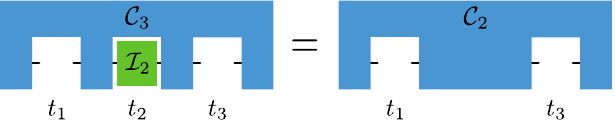
FIG. 6. Generalized marginalization for combs. Letting a comb defined on times T act on identity maps at a set of times T n T 0 (i.e., the set of times in T but not in T 0 ) yields the correct comb on T 0 . Depicted is the situation for T ¼ f t 1 ; t 2 ; t 3 g and T 0 ¼ f t 1 ; t 3 g